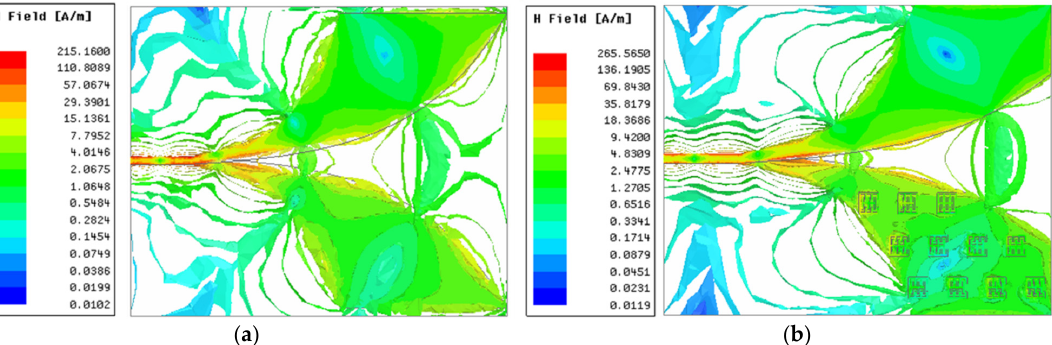
Figure 12. Magnetic field distribution in the Vivaldi antenna at 5 GHz ( a ) without and ( b ) with the metamaterial.